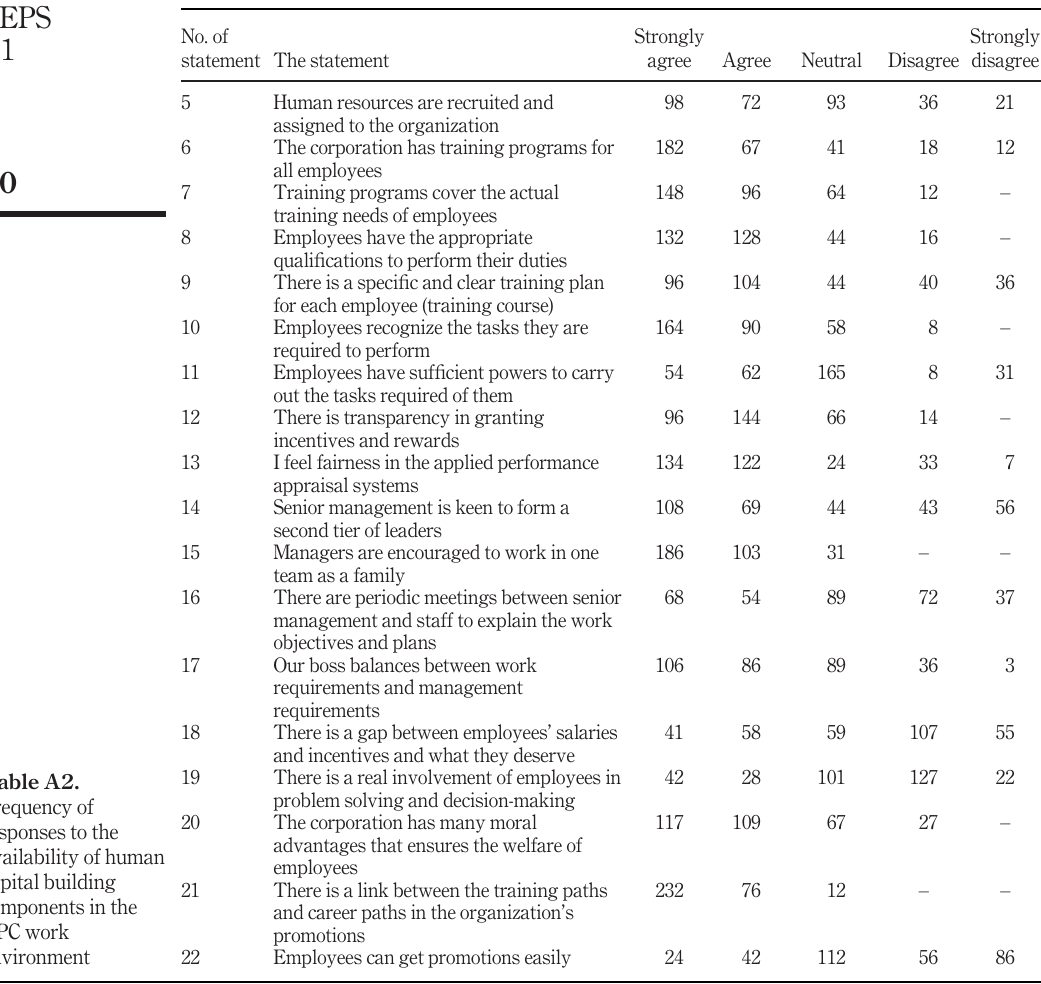
Table A2. Frequency of responses to the availability of human capital building components in the KPC work